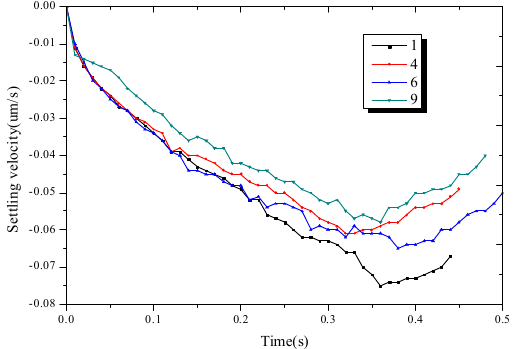
Figure 10. The falling velocity of dendrite 1, dendrite 4, dendrite 6, dendrite 9.